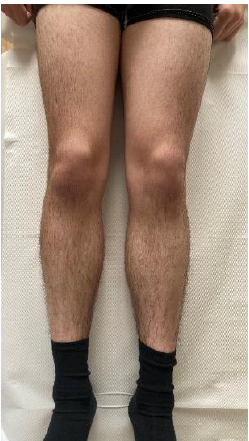
Figure 7. Postoperative condition in the operating room: an approximately 2-centimeter incision.